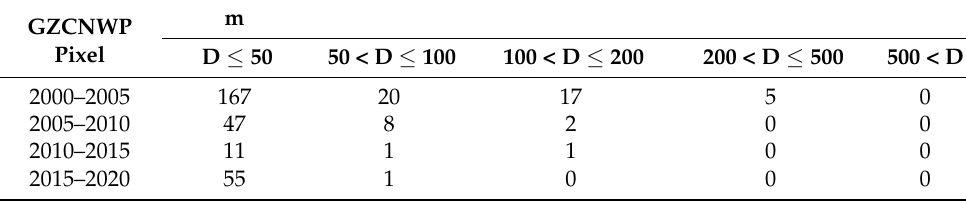
Table A2. The quantity relationship of lost mangrove pixels and the distances between mangroves and driving factors in